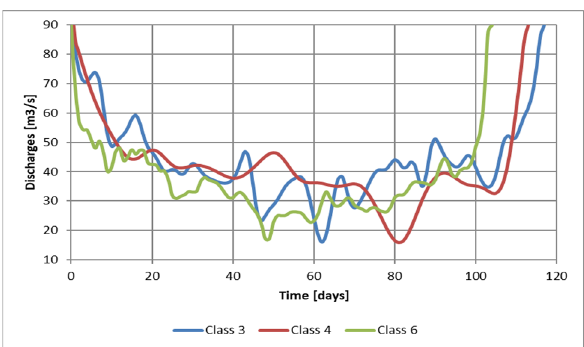
; V 1% ) ; ( Q min ; V 5% ) ; ( Q min ; V 10% ) 99% 95% 90%